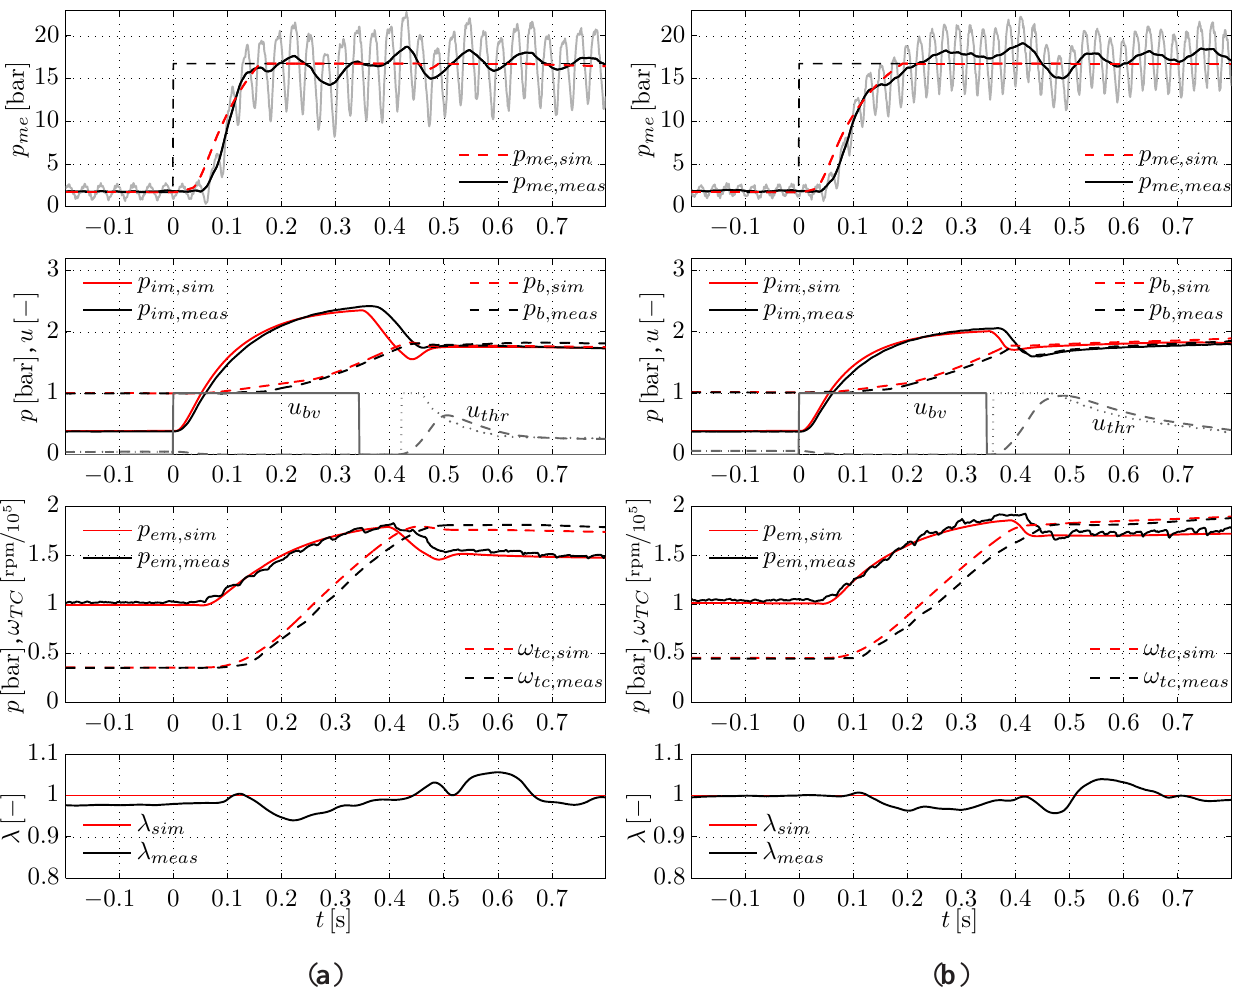
Figure 8. Comparison of measurement (black) and simulation (red) for load steps from 1.7 bar to 16.7 bar p . ( a ): ω = 2000 rpm ; ( b ): ω = 2500 rpm . The measurement data me e e are averaged over one engine revolution. In addition, the unfiltered value of p in